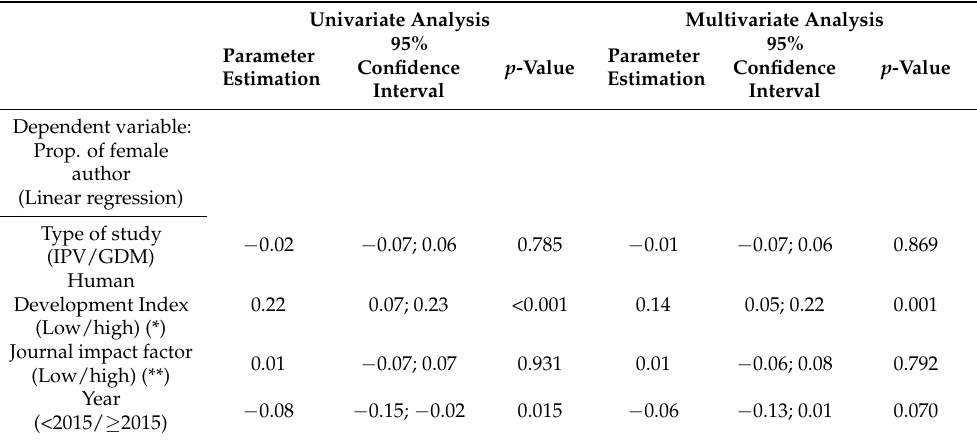
Table 2. Multivariate regression estimates the proportion of female author gender among prevalence studies of intimate partner violence (IPV) during pregnancy and prevalence of gestational diabetes mellitus (GDM) included.